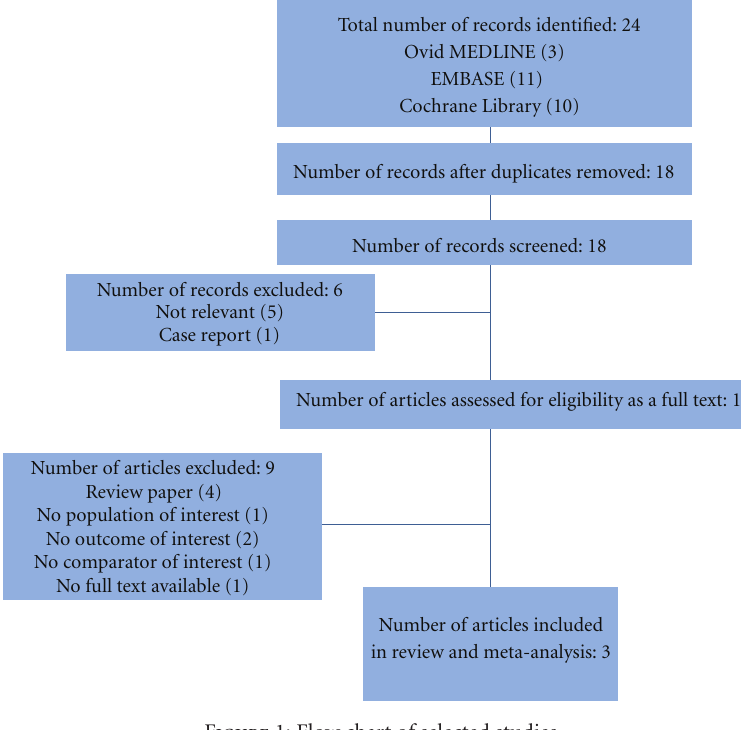
Figure 1: Flow chart of selected